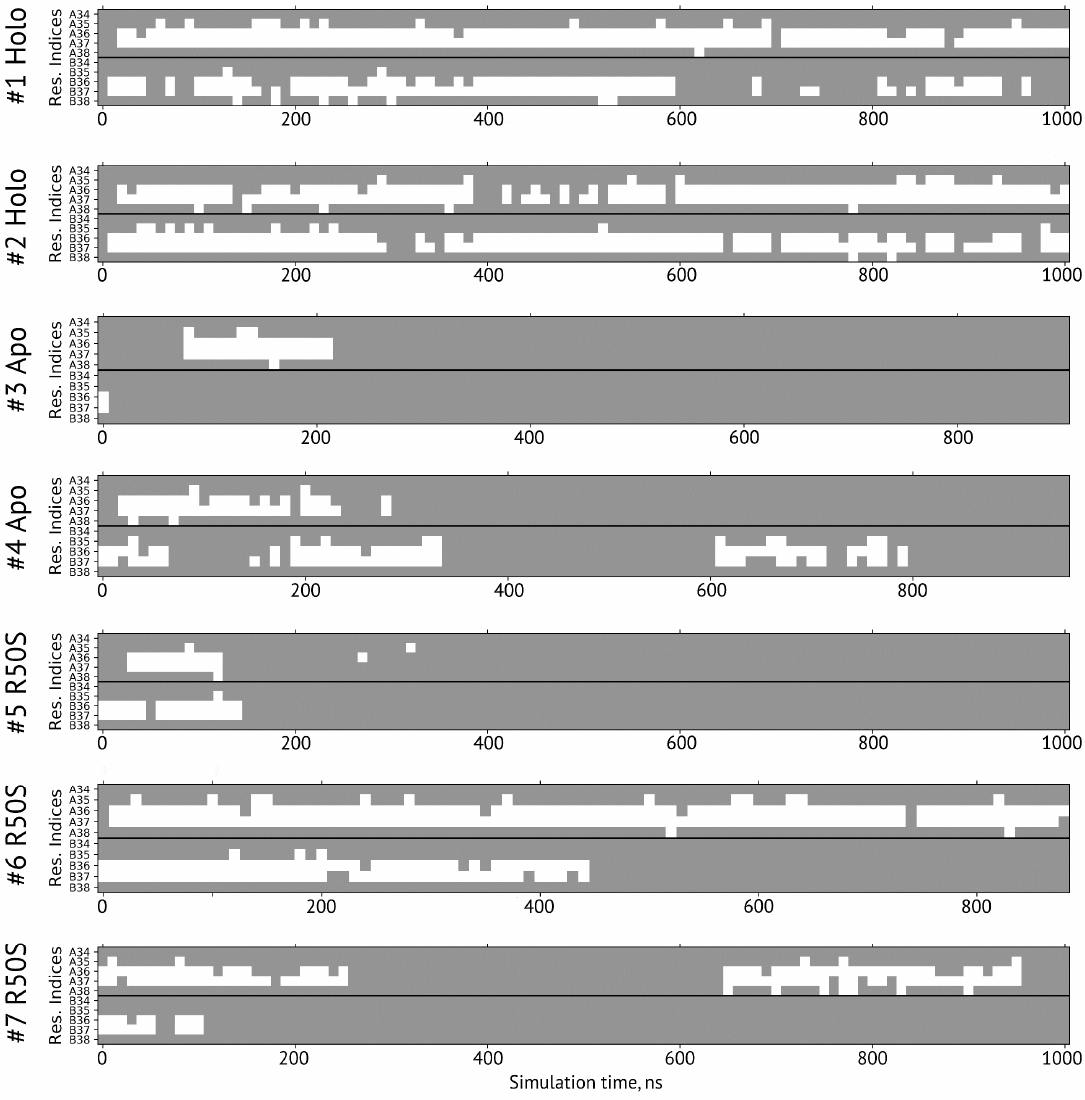
Figure 6. Secondary structure of the residues 34–38 forming the sensor-TM linker in simulations. A and B denote the two protomers in the NarQ homodimer. The residues with the ϕ and ψ angles characteristic of α -helical conformation are shown in gray, and those in disordered state are shown in white.